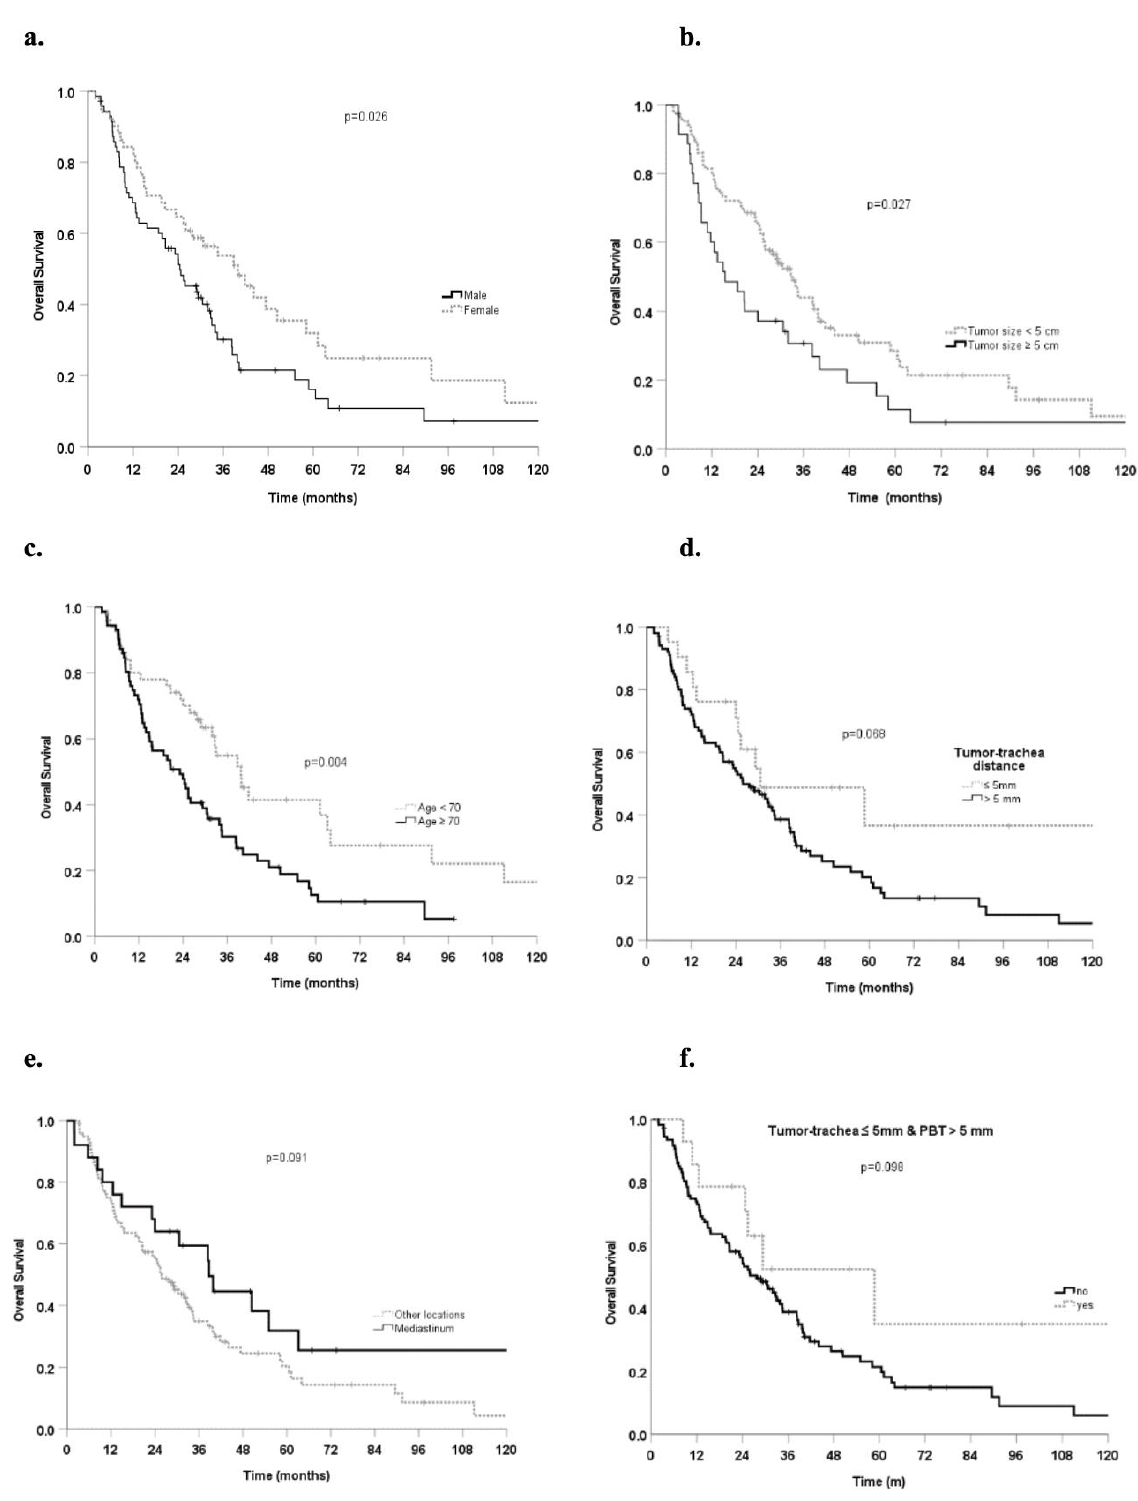
Figure 1. ( a ) Overall survival for male and female patients, ( b ) patients with tumor sizes < or ≥ 5 cm, ( c ) aged < or ≥ 70 years, ( d ) with tumor-trachea distance ≤ or > 5 mm ( e ) treated for mediastinal tumors vs. the other locations and ( f ) patients with distance from tumor to the trachea ≤ 5 mm and to the PBT > 5